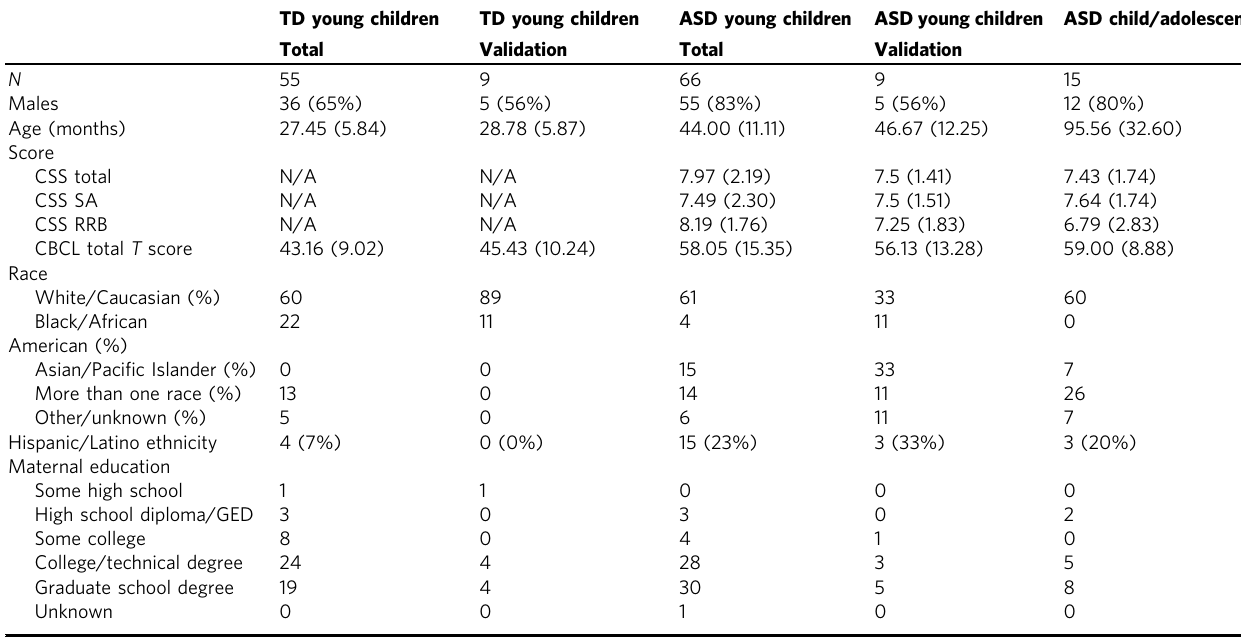
Table 1 Demographics and descriptive